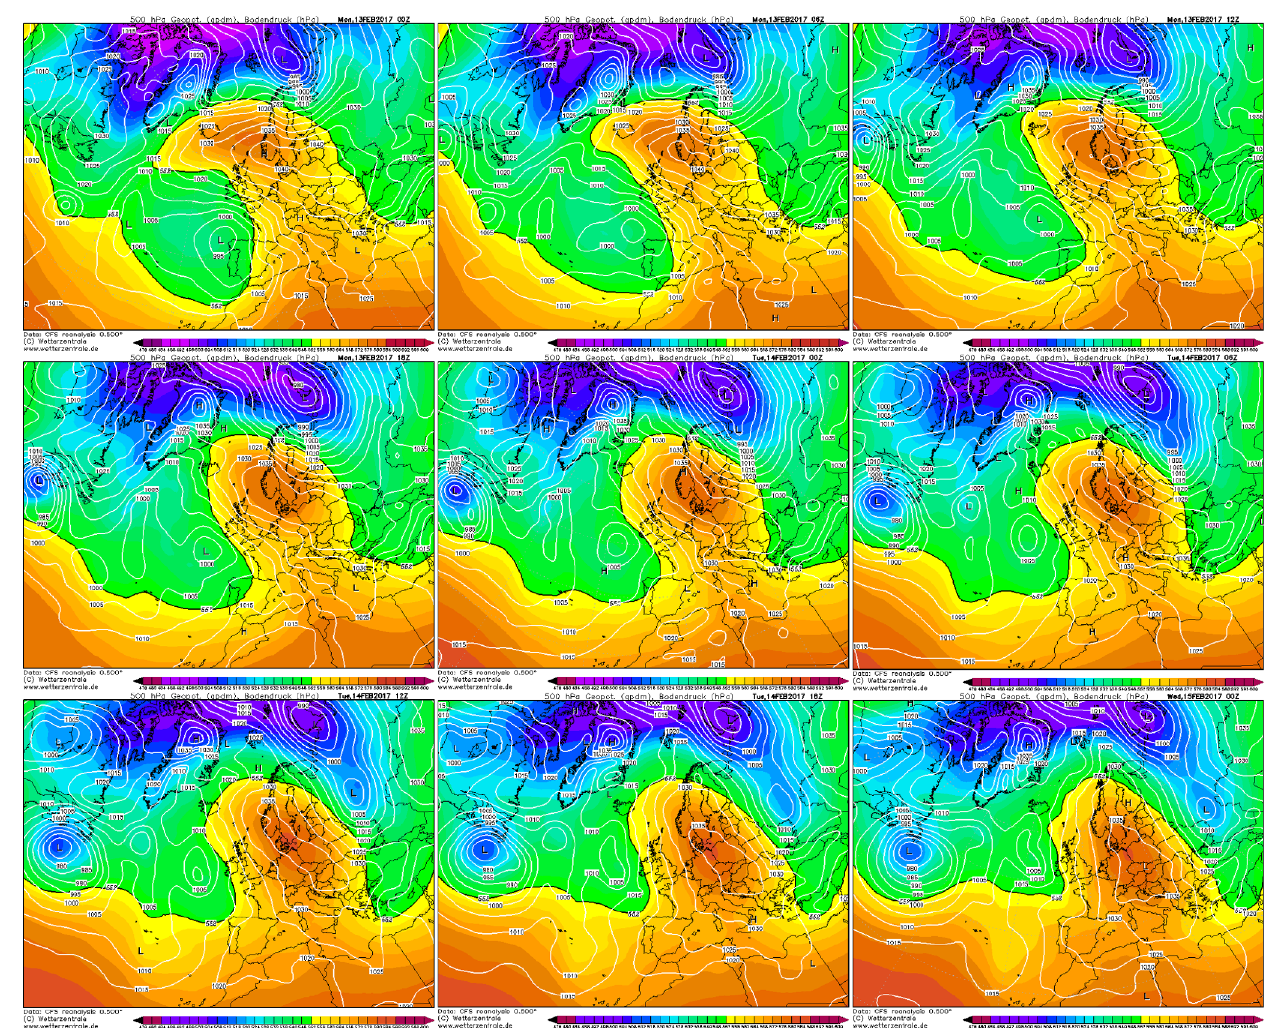
Figure 5. CFS reanalyses of geopotential height at 500hPa from 13 February 2017 00:00UTC to 15 February 2017 00:00UTC (https: //www.wetterzentrale.de/, last access: January